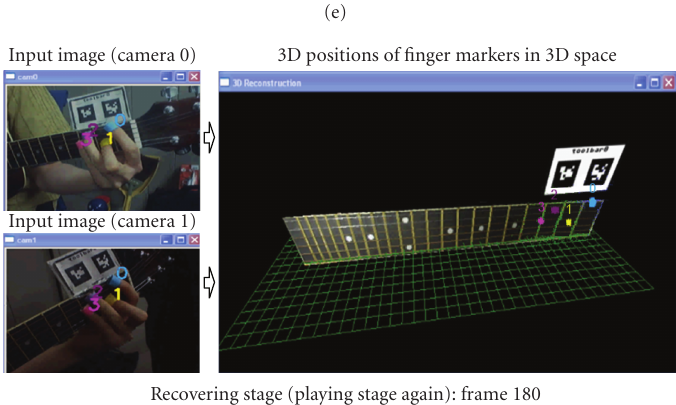
(iii) The conditional probability P ( c | m ) of a marker